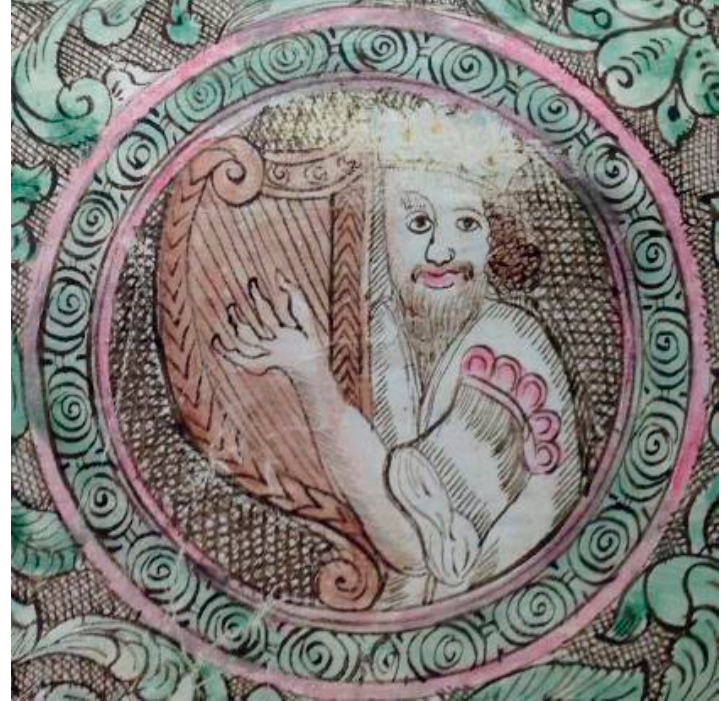
Figure 9. King David. Passover Haggadah”, Ihringen, 1732; Jerusalem, The Israel Museum, Ms. 181/48, Fol. 3r. Used by permission.